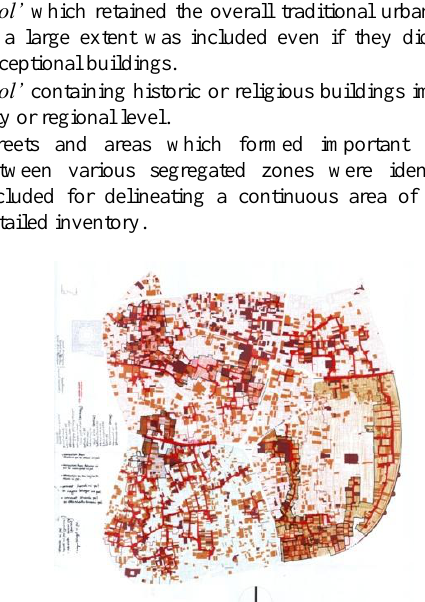
Figure 1. Reconnaissance survey & Identification of study